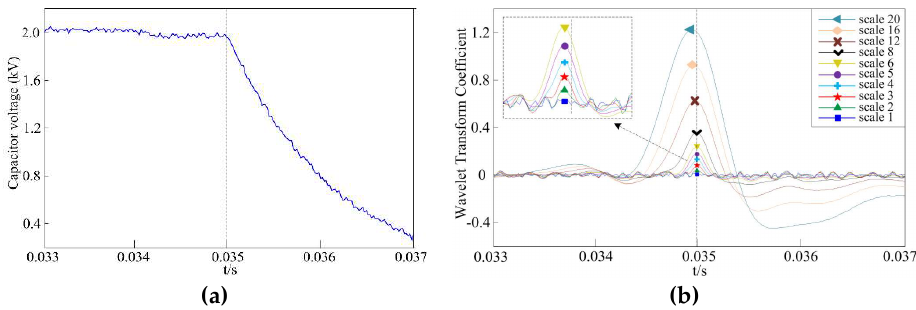
Figure 11. Fault location result with 40-db white Gaussian noise for Case 2: ( a ) Contaminated capacitor voltage; ( b ) Wavelet Transform Coefficients under various scales.